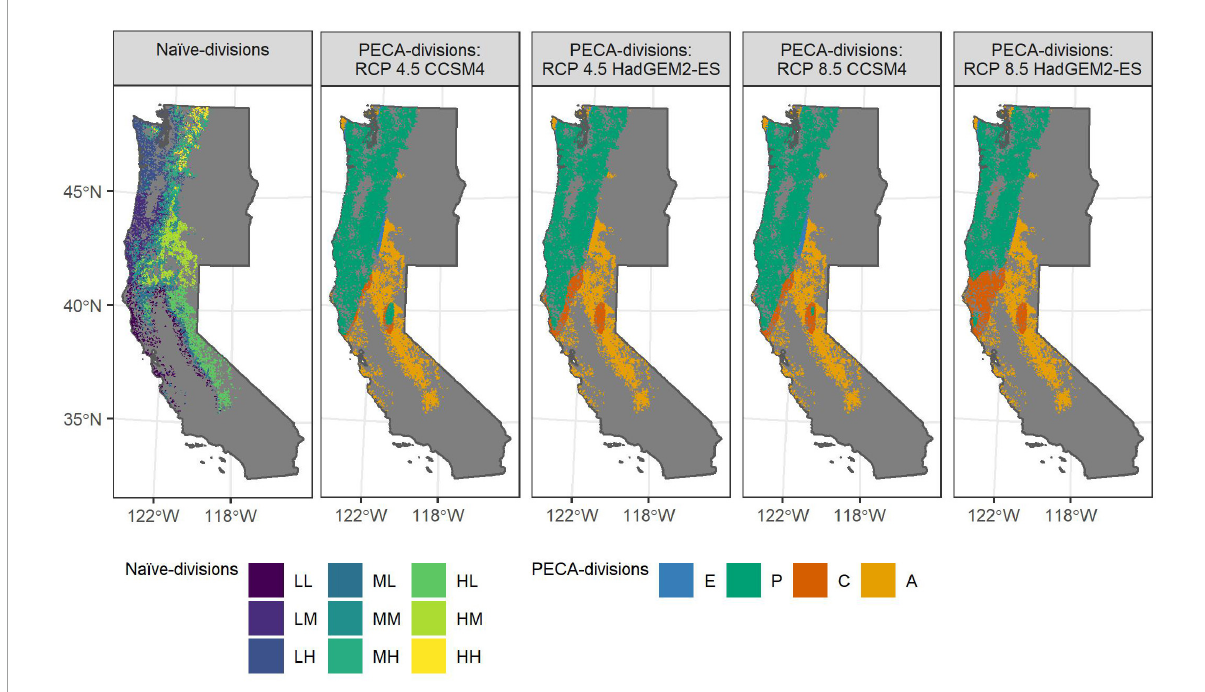
FIGURE1 For coastal Douglas-fir, maps of FIA plots within the species’ study area where plots are colored by the naïve-division and by the most commonly assigned PECA-division (across the 100 MCMC samples) under each of the four future climate scenarios. Future climate scenarios are organized from left to right by increasing severity, from the mildest scenario (RCP 4.5 CCSM4) to the most severe (RCP 8.5 HadGEM2-ES). The first and second letters of the naive-divisions code ( Table 2 ) corresponds to the elevation-partition and the latitude-partition, respectively; e.g., ML is the mid-elevation, low-latitude naïve-division. PECA-divisions correspond to areas of projected range expansion (E), persistence (P), contraction (C), or where habitat for the species was projected to remain unsuitable (A).